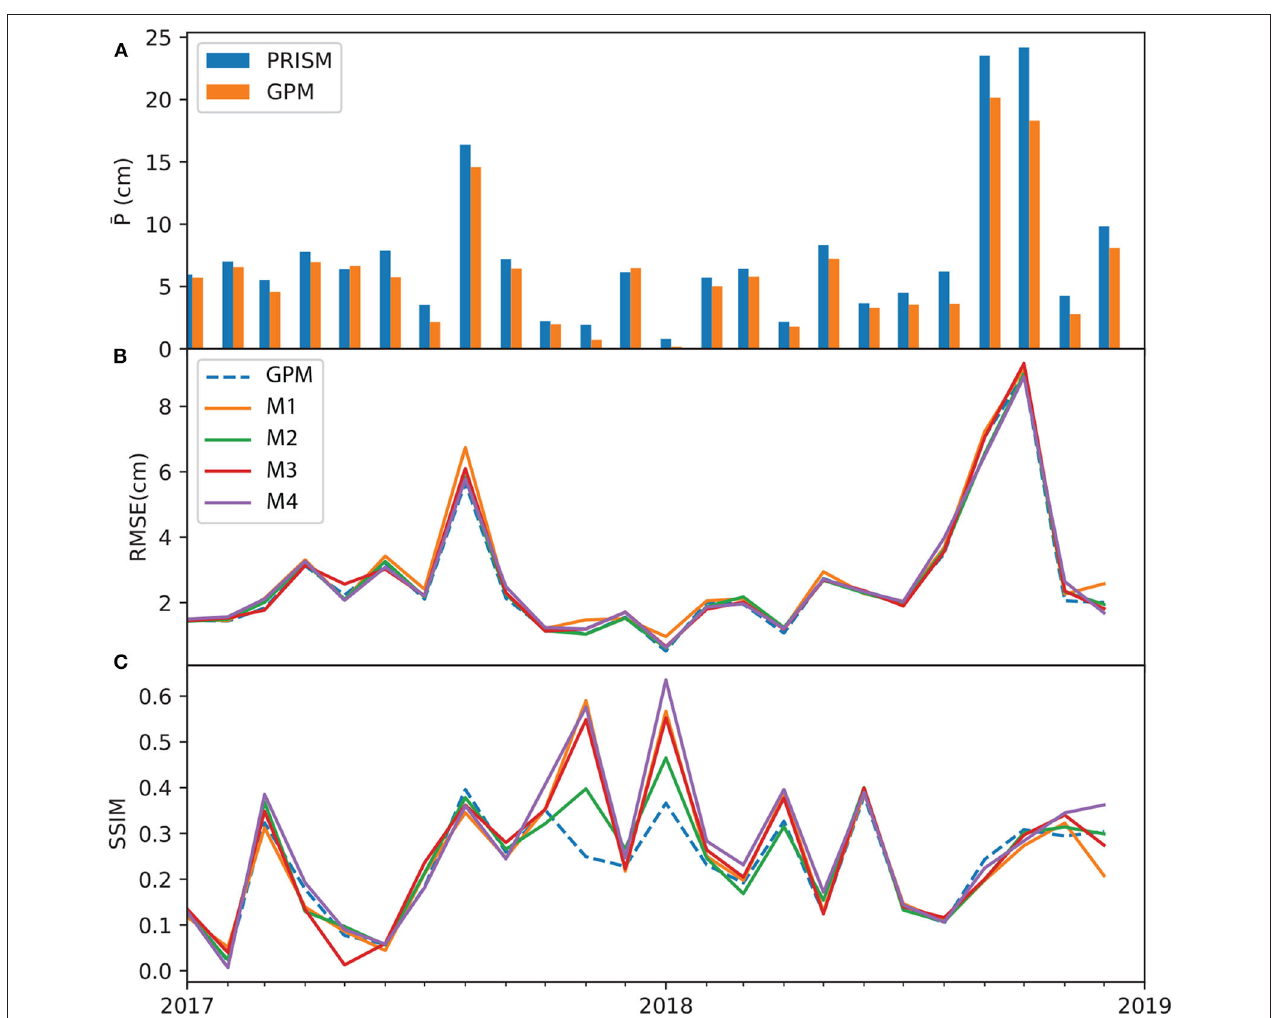
FIGURE 8 | Time series of GPM metrics over the test period: (A) monthly averaged PRISM and GPM data; (B) mean grid averaged RMSE; and (C) SSIM. All subplots share the same x